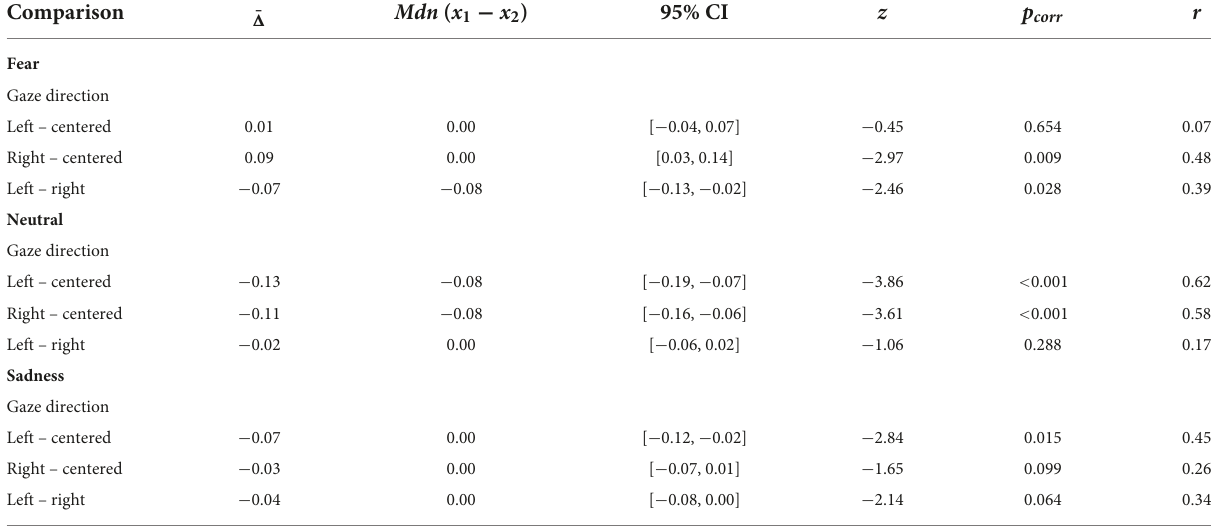
TABLE 1 Experiment 1: Results of the Wilcoxon signed-rank tests for correct emotion recognition (percentages given as decimals) ( N = 39).